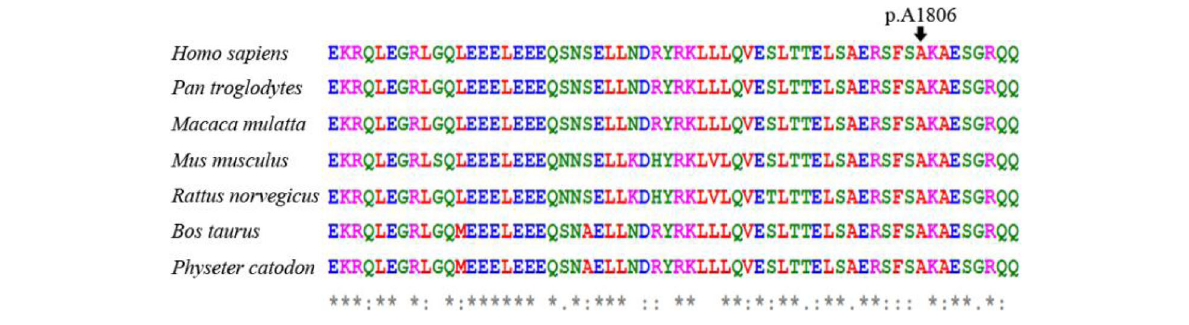
Fig. 4 The protein alignment shows conservation across seven species. The mutation c.5417C> A occurred at evolutionarily conserved amino acids